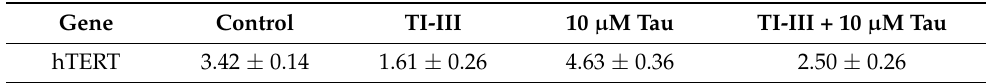
Table 6. hTERT protein expression.